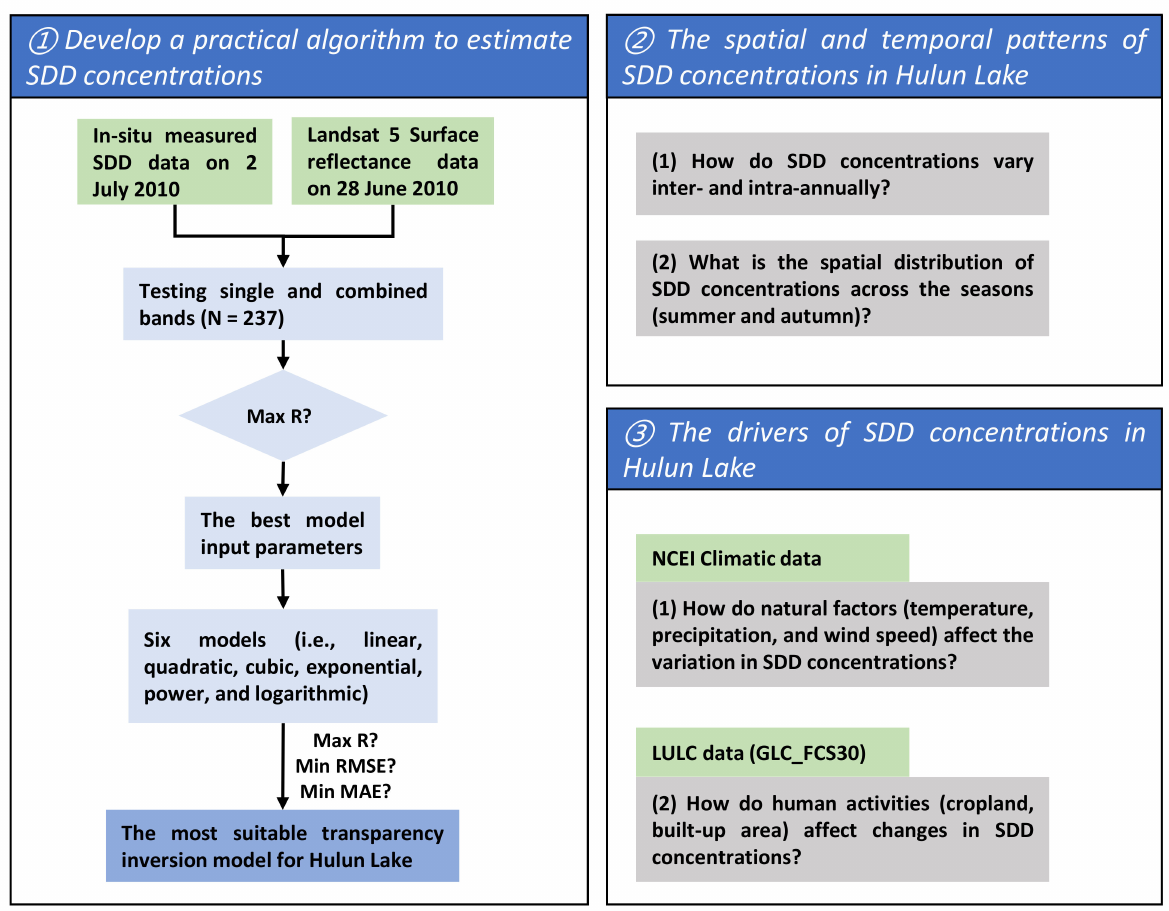
Figure 1. Flowchart diagram of methodology. Note, R represents the Pearson correlation coefficient, RMSE represent the root mean square error, and MAE represents the mean absolute